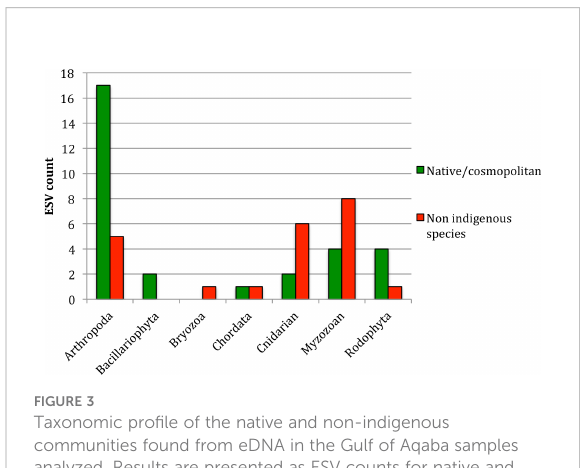
FIGURE 3 Taxonomic pro fi le of the native and non-indigenous communities found from eDNA in the Gulf of Aqaba samples analyzed. Results are presented as ESV counts for native and non-indigenous species, per